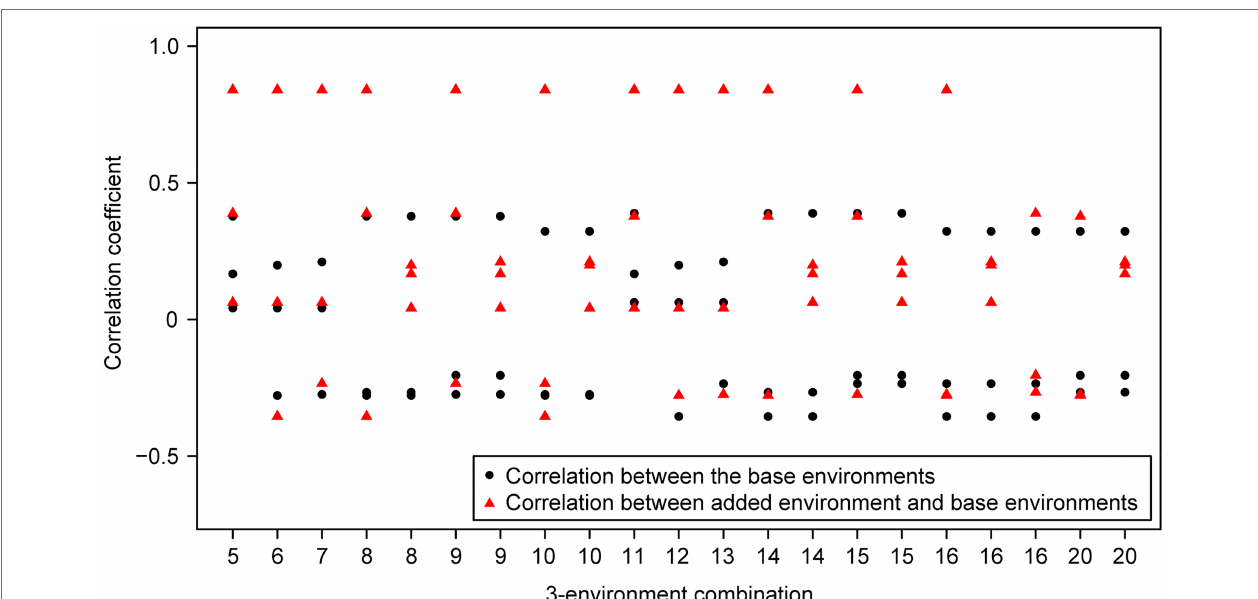
FIGURE 3 | Wheat – 3-environment combinations with complete phenotypic values showing statistically significant ( p < 0.05) lower response to selection than their extended 4-environment combinations using genomics-assisted sparse phenotyping. Labels of horizontal axis are the scenario numbers of 3-environment combinations. Black dots represent correlation coefficients between the three base environments with complete phenotypic values. Red triangles indicate correlation coefficients between the added environment and base